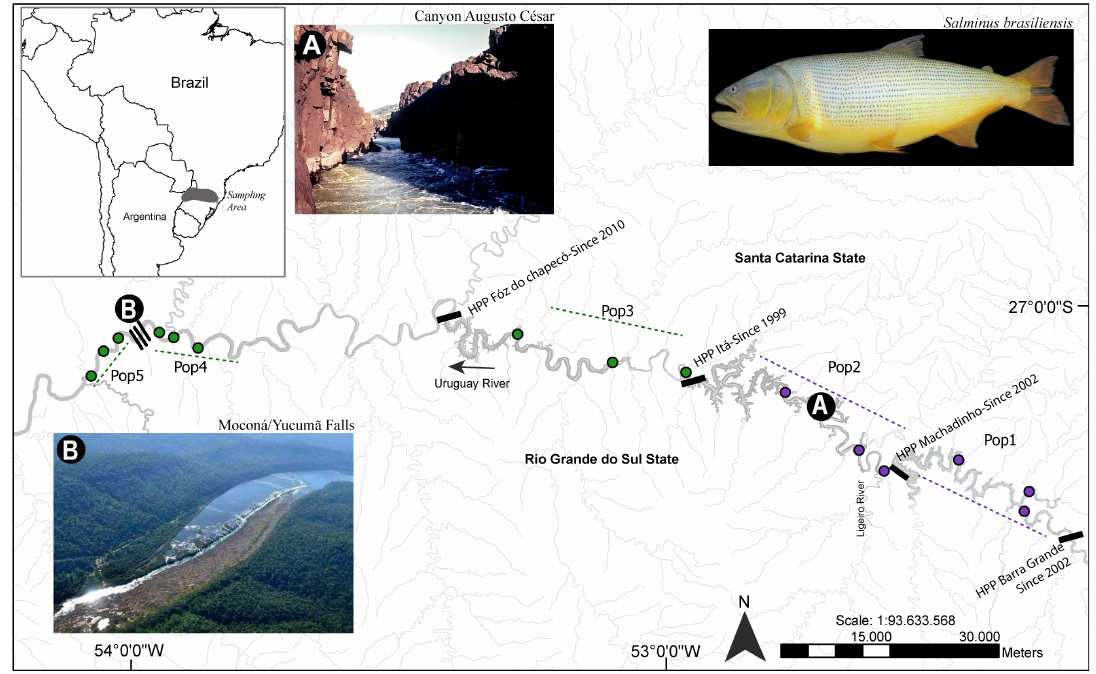
FIGURE 1 | Study area of Salminus brasiliensis populations in the Uruguay River basin, southern Brazil. A . Picture of Canyon Agusto César Gorge, Upper Uruguay River (acquired rights); B . Picture of Yucumã our Moconá Falls (google font: https://7mar.com.ar/mocona). Salminus brasiliensis (personal